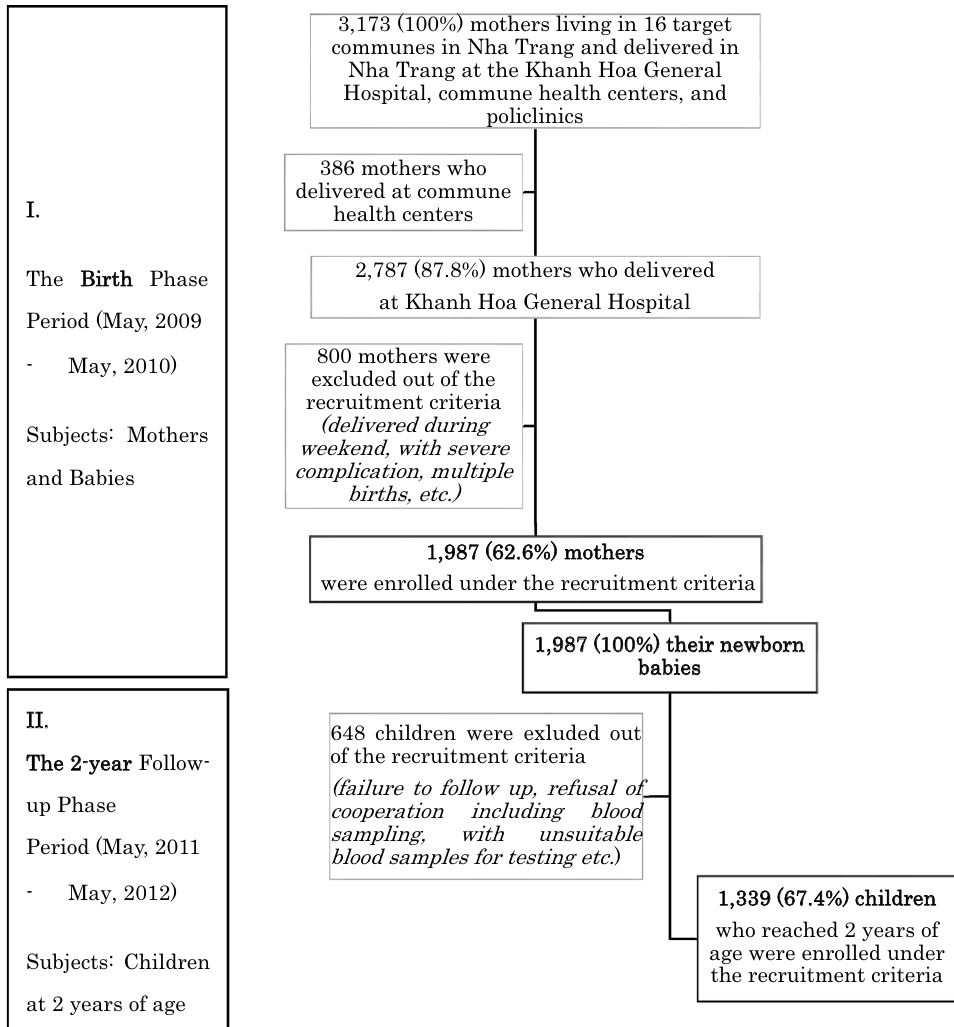
Figure 1. Study algorithm on enrollment of the subjects, Nha Trang, Vietnam, 2009–2012. This figure represents the study algorithm on enrollment of the subjects. I. During the birth phase period in May, 2009– May, 2010, a total of 3,173 mothers living in 16 target communes in Nha Trang delivered at either the Khanh Hoa General Hospital and commune health centers. Of them, 2,787 (87.8%) delivered at the hospital and 1,987 (62.6%) mothers and their 1,987 newborn babies were enrolled under the criteria. II. During the 2-year follow-up phase period in May, 2011–May, 2012, among these 1,987 neonates enrolled in the birth phase, 1,339 (67.4%) children who reached 2 years of age were enrolled under the